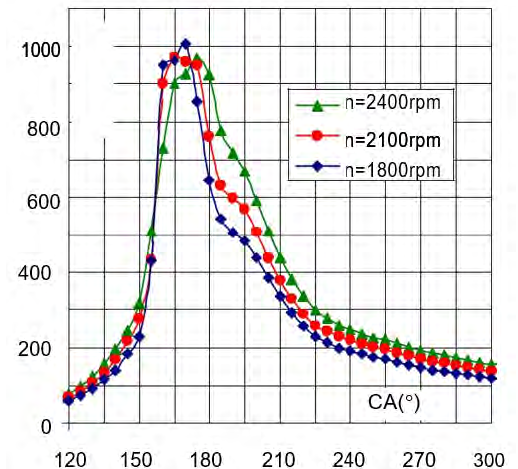
Figure 13. Variation of X O 2 ε /k in function ofcrank angle with different engine speeds (D20, =1)